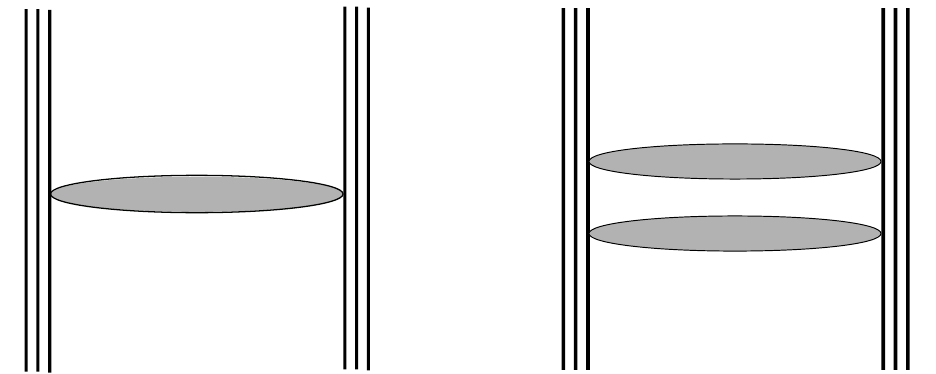
Figure 4. One and two gluon bundles exchange between two quarks of two